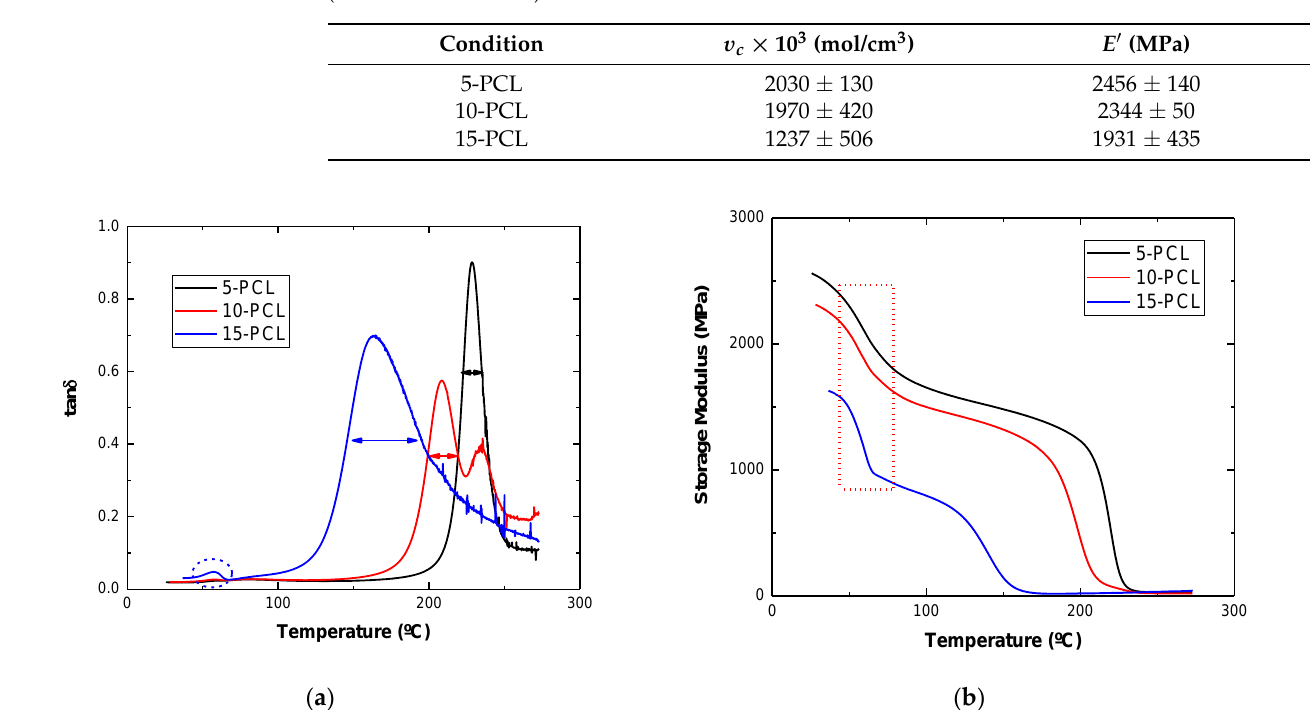
Figure 4. Results of the DMTA tests showing ( a ) the evolution of tanδ and ( b ) the variation in the storage modulus with the temperature for the different conditions.